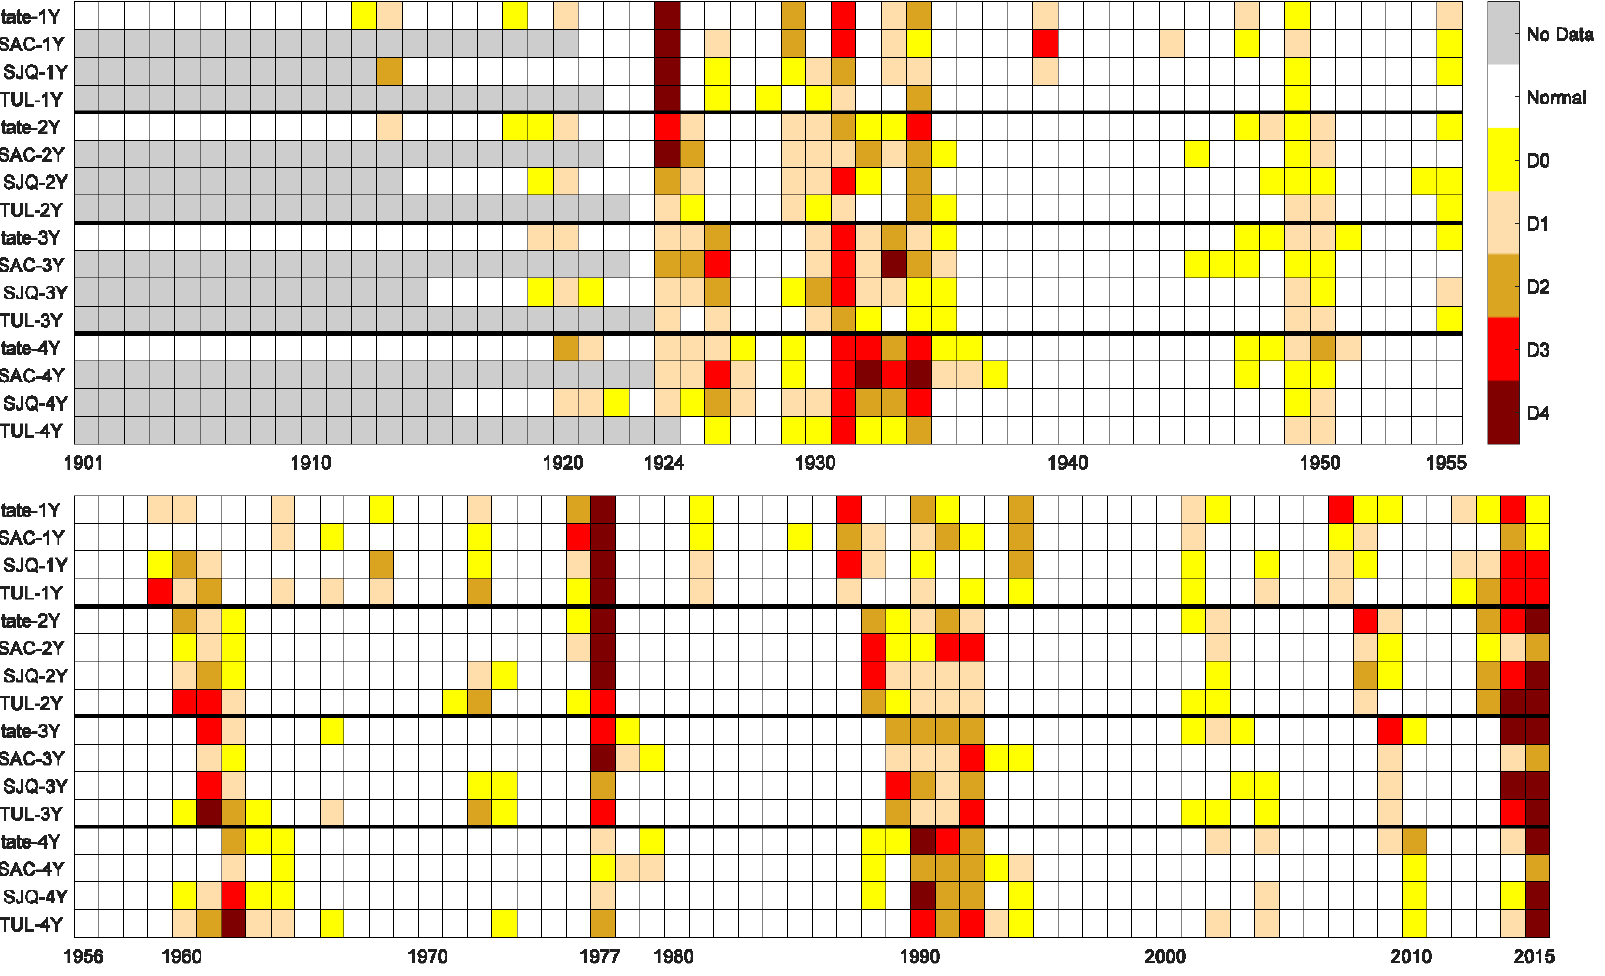
Figure 4. Drought monitor categories for statewide precipitation as well as major precipitation indices at different levels of periods (one- to four-year). At two-year, three-year, and four-year levels, the label of X -axis indicates the end year of the specific period. “Y” in the label of Y -axis stands for “Year”.